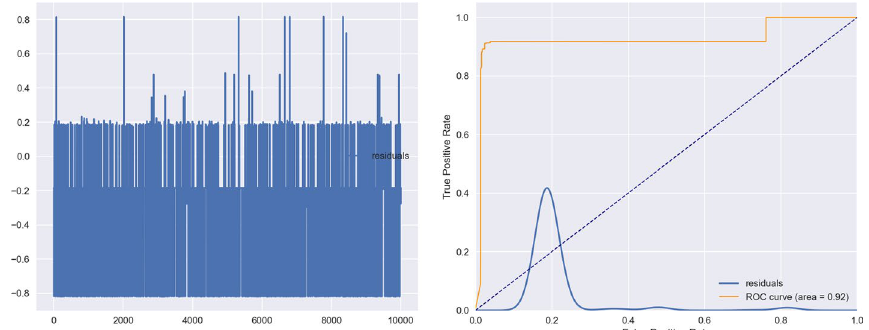
Fig. 7 Results of applying XGBoost to D03 original timed order. Right: ROC curve and residual distribution